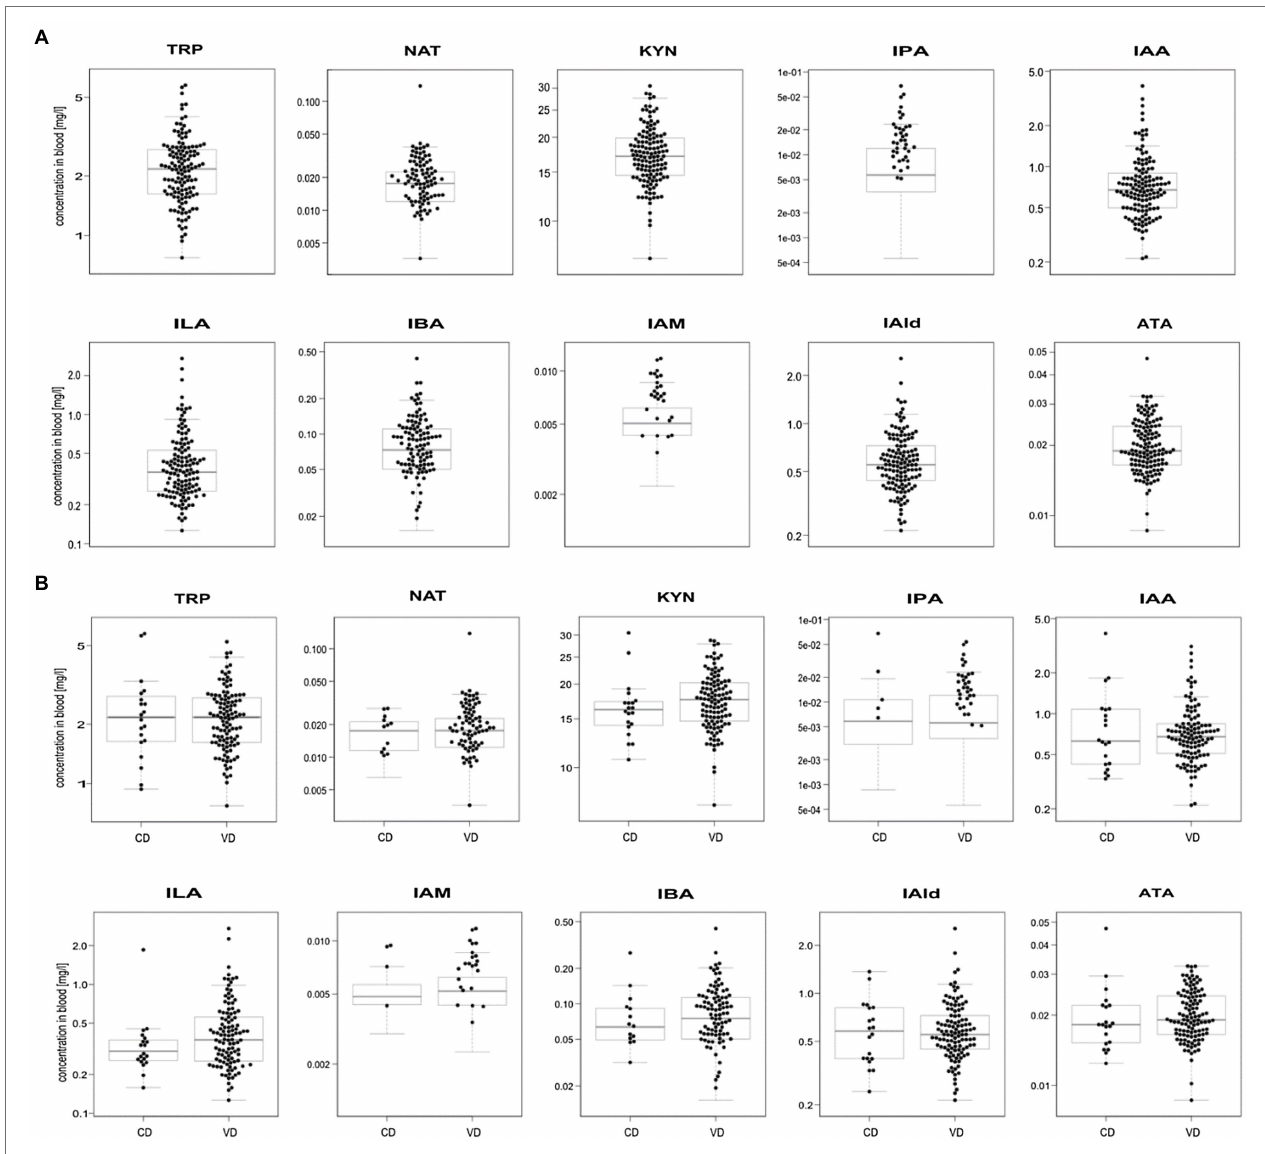
FIGURE 2 | Boxplots of metabolite levels were determined in 134 neonatal DBS (A) and grouped according to the delivery mode (VD, vaginal delivery, CD, cesarean delivery; B ). Sample concentrations >LOQ marked with black dots. Y-axis is in